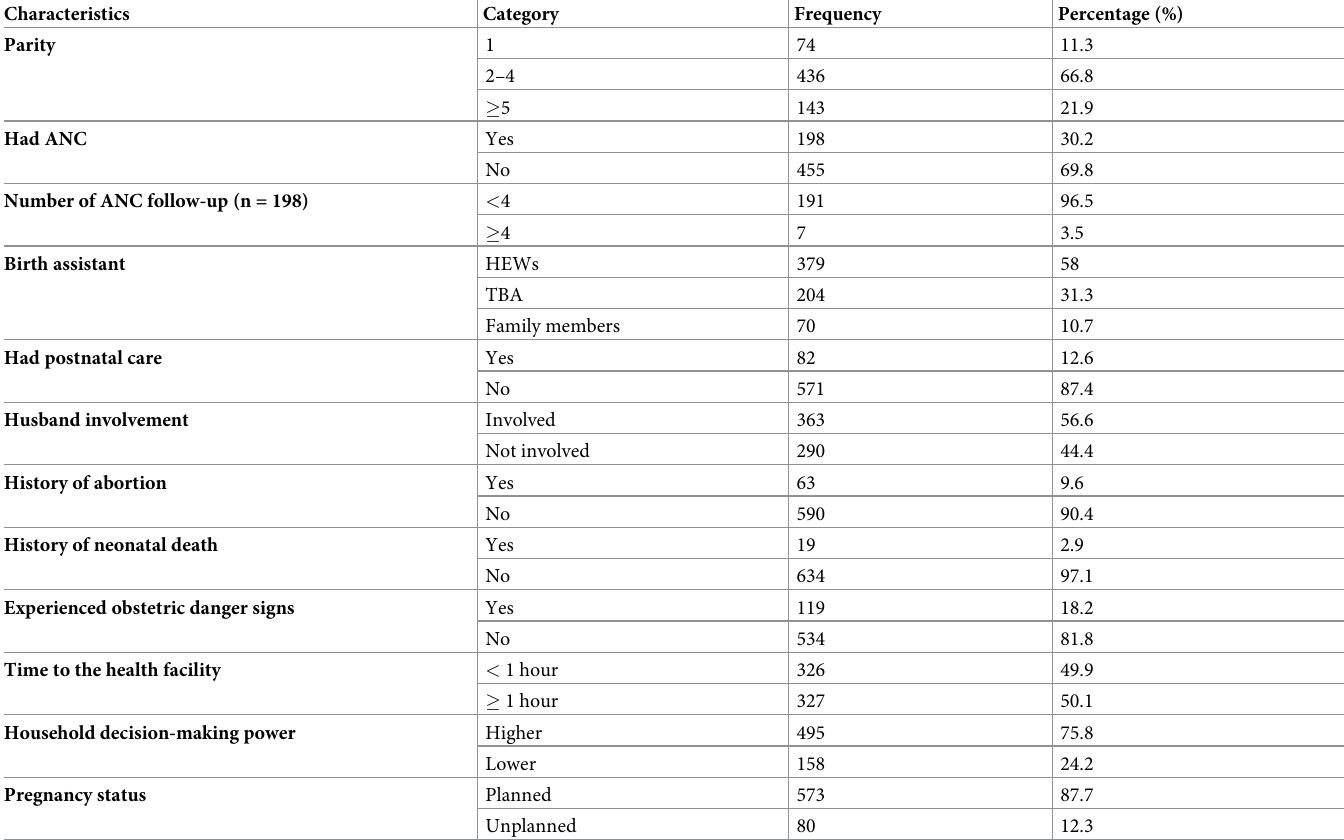
Table 2. Reproductive and maternity healthcare service characteristics of the study participants in rural Sehala Seyemit district, northern Ethiopia, 2020 (n = 653).